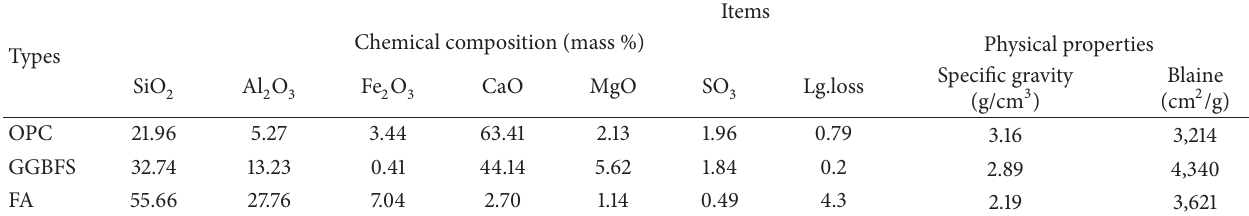
Table 1: Chemical composition and physical properties of OPC, GGBFS, and